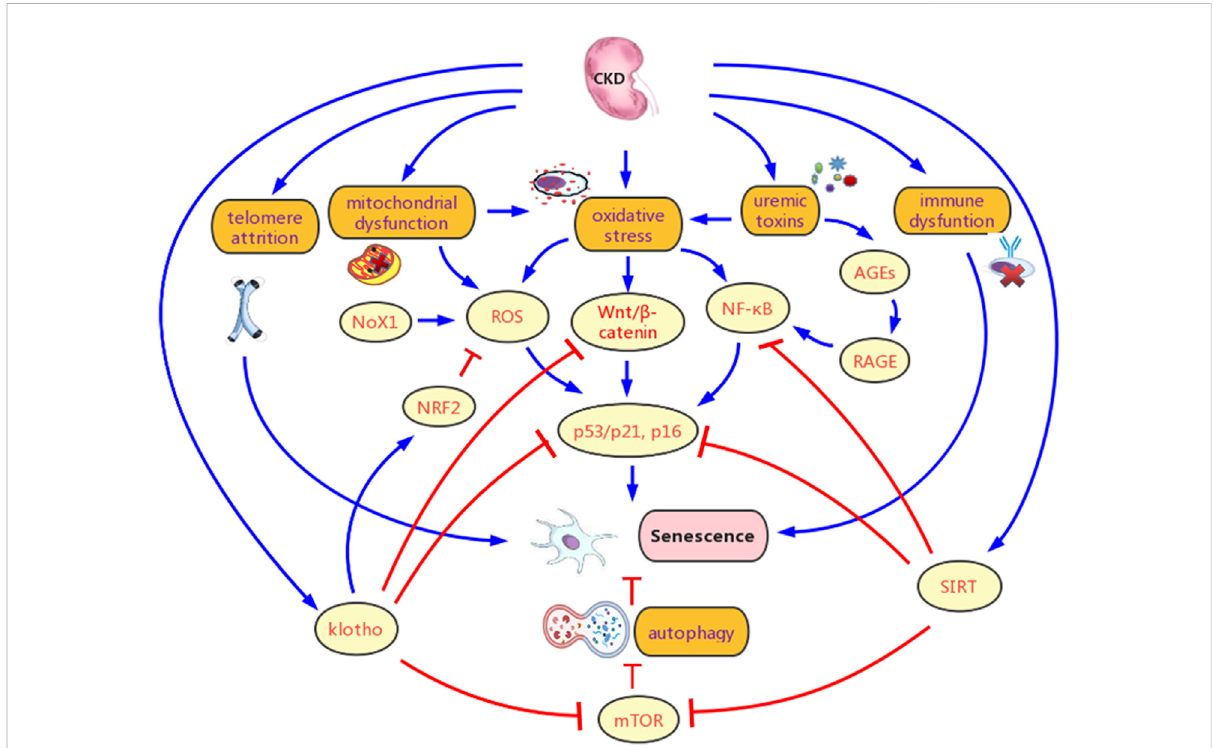
FIGURE 3 Potentialmechanismsforchronickidneydisease(CKD)promotingsenescence.CKDcontributestosenescencemainlybyMultiplepathological productsofCKDleadstochronicin fl ammation,oxidativestress,andmetabolicabnormalityinthekidney,whichcontributestosenescence.Besides, telomere attrition, klotho defect, sirtuins (SIRTs) de fi ciency, autophagy inhibition, and immune dysfunction are also important causes for increased senescence.VarioussignalingpathwaysareinvolvedinthepromotionofsenescenceinCKD,mainlyincludefactor-erythroid2-relatedfactor2 (NRF2),Wnt/ β -catenin,NF- κ B,andmTOR.AGEs,advancedglycationendproducts;RAGE,AGE-receptorforadvancedglycationendproducts;ROS, reactive oxygen